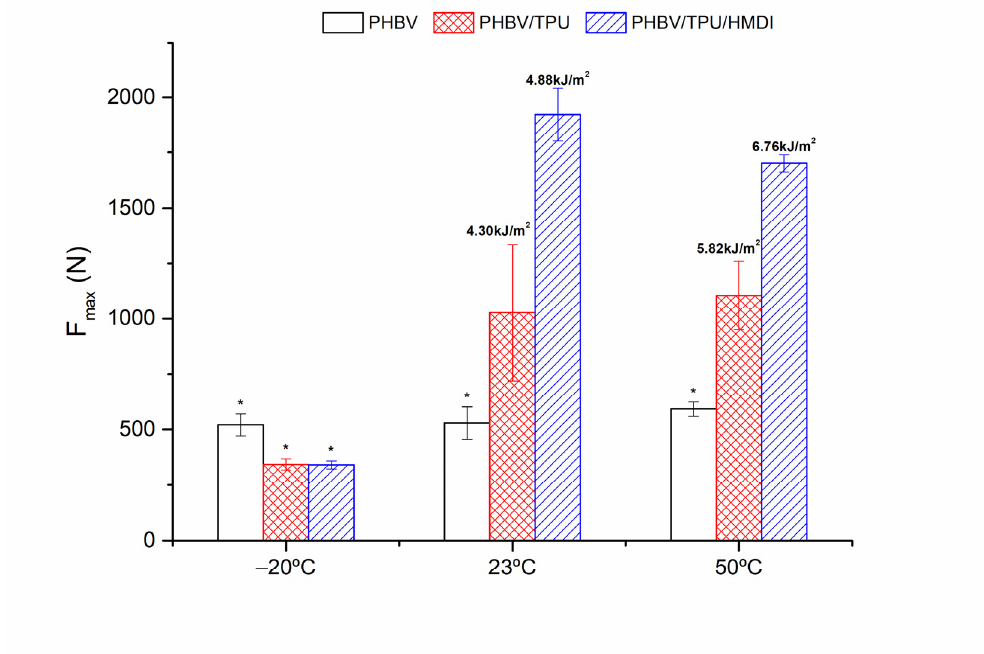
Figure 11. The maximum force in the dart drop impact test. The absorbed impact energy is indicated on top of each bar in the figure. Asterisks (*) indicate that these samples were broken with the formation of splinters.